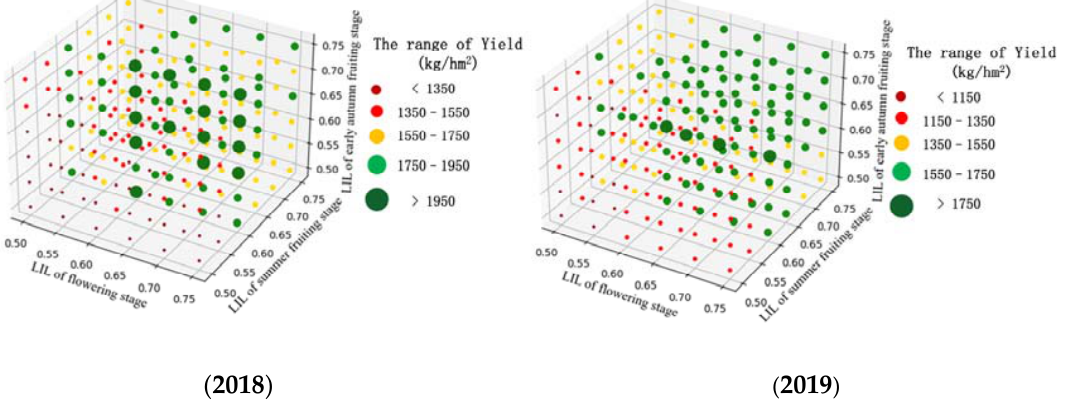
Figure 7. Scatterplot of relationship between lower irrigation limit and yield at different growth stages.